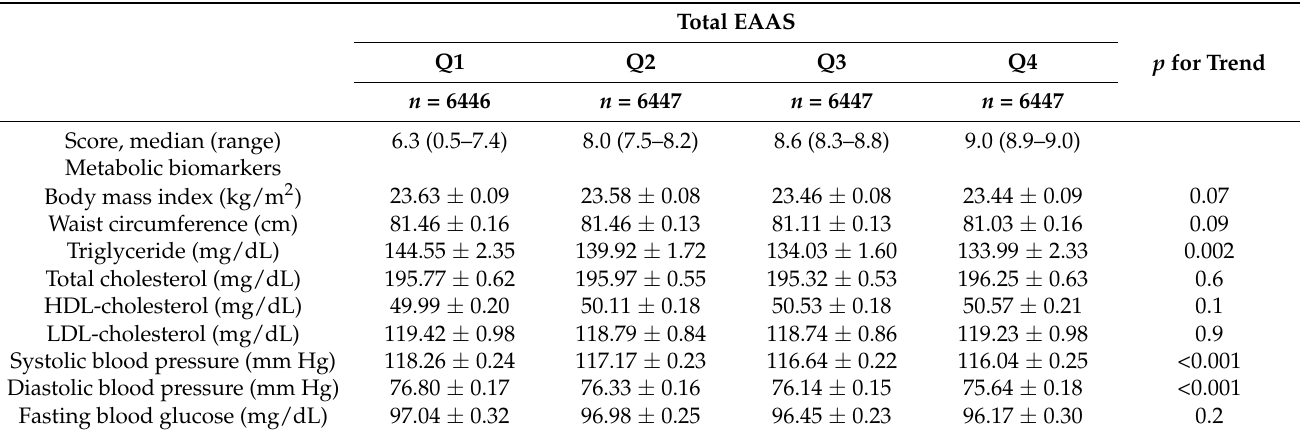
Table 2. Adjusted average levels of metabolic biomarkers according to the total EAAS, KNHANES 2008–2019 ( n =